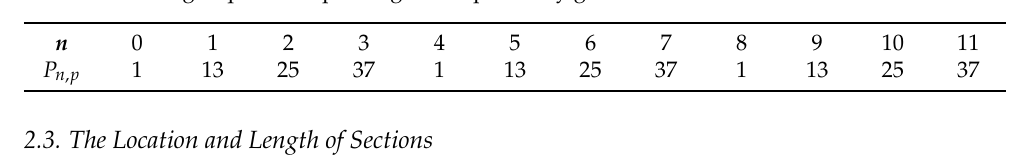
Table 3. Meshing sequence of planet gear for planetary gearbox